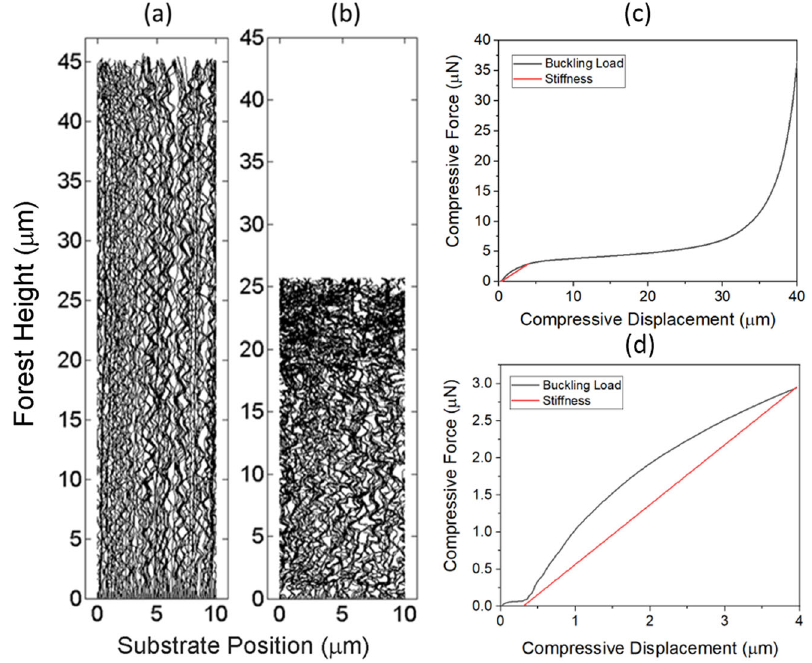
Fig. 3 Simulated CNT forest compression. An expanded CNT forest compression demonstration showing the simulated CNT forest morphology ( a ) at the beginning of compression and ( b ) after 20 μ m compression. c The full load – displacement curve shows the typical linear-elastic regime at low displacement, an extended plateau, and a densi fi cation regime. d A magni fi ed view of the loading curve shown in ( c ) illustrates the evaluation of forest stiffness and buckling load.